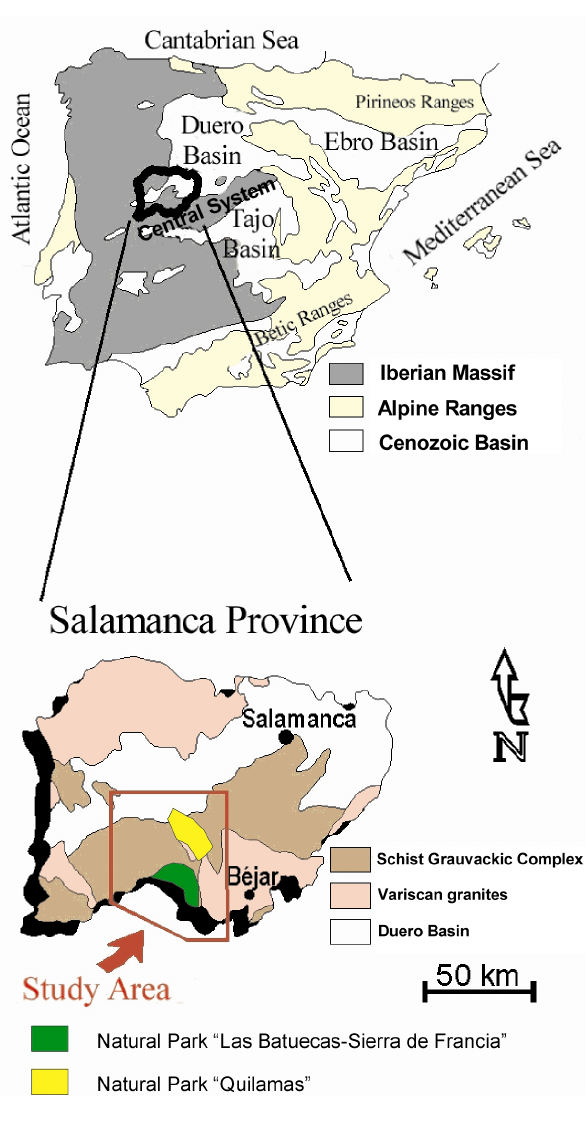
Figure 1. Study area: Protected natural park “Las Batuecas-Sierra de Francia” and